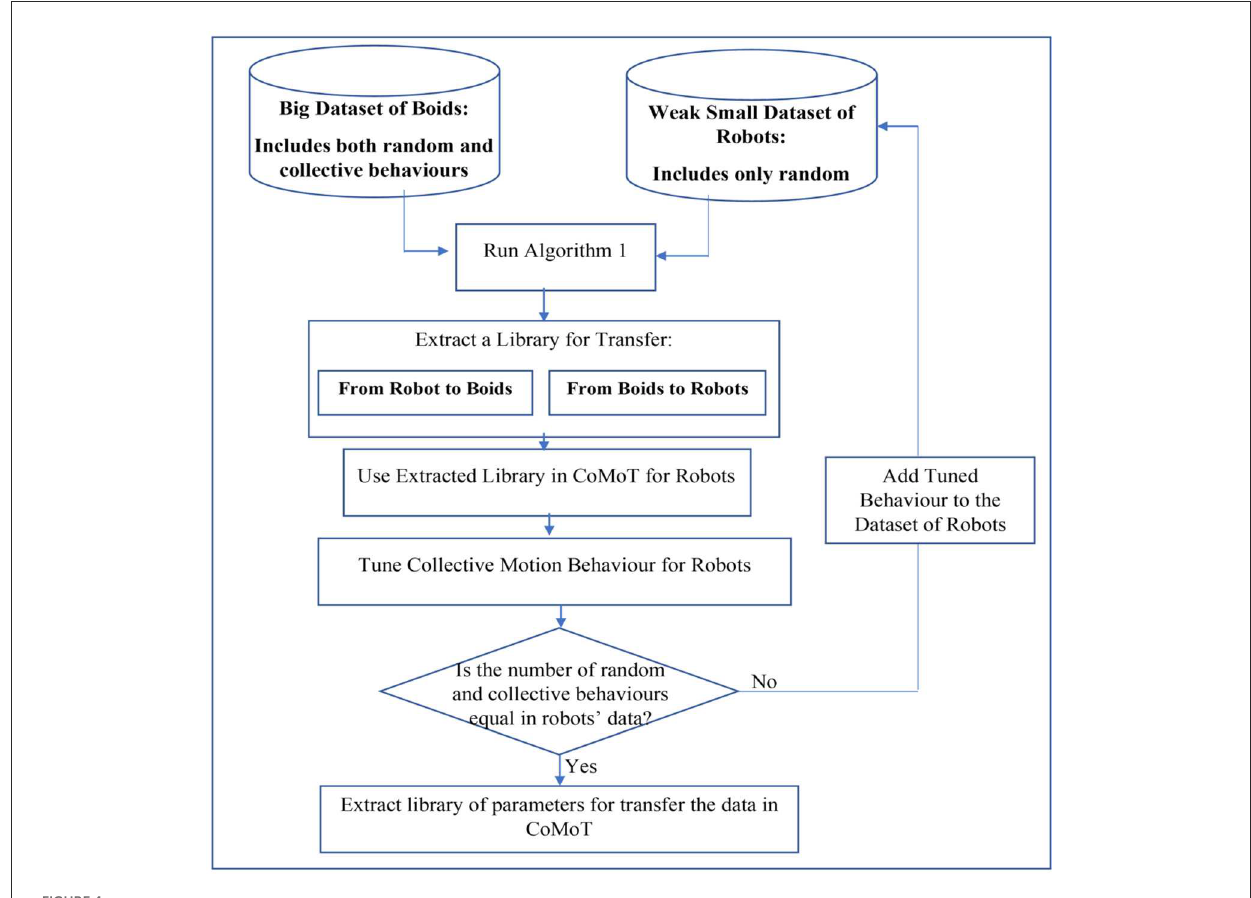
FIGURE4 Iterative transfer learning to extract a library for CoMoT.